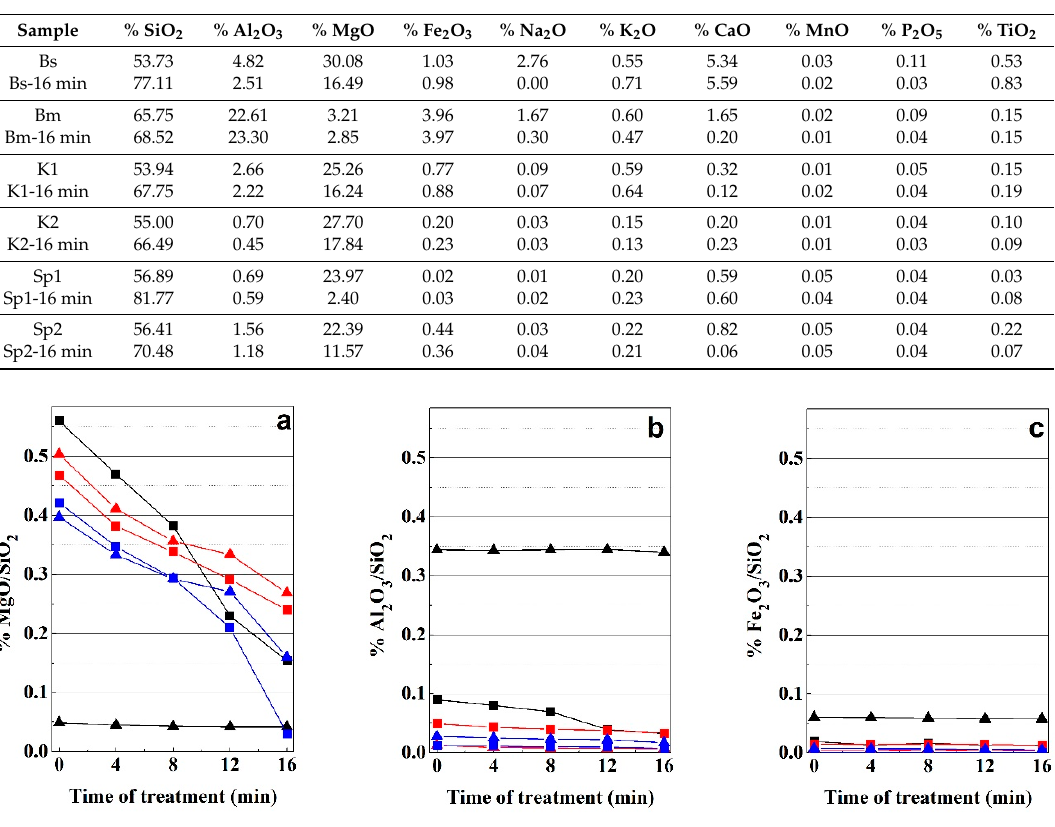
Figure 5. Variation of MgO/SiO 2 ( a ), Al 2 O 3 /SiO 2 ( b ), and Fe 2 O 3 /SiO 2 ( c ) along the experiments: Bm (black triangle), Bs (black square), K1 (red square), K1 (red triangle), Sp1 (blue square), Sp2 (blue triangle).